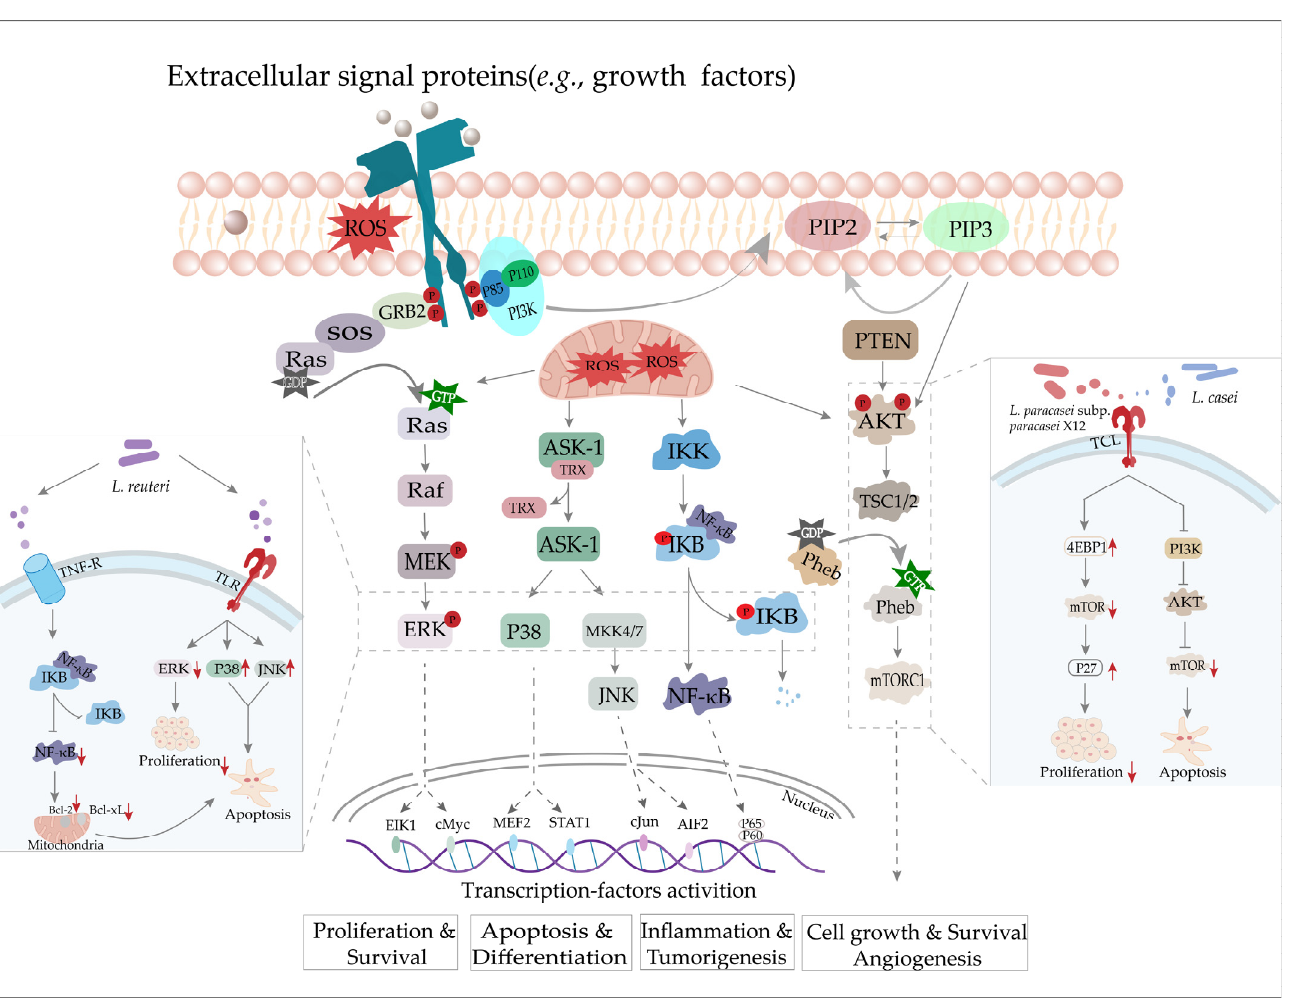
Figure 2. ROS induces the activation of the MAPK, NF- κ B, and PI3K/PTEN signaling pathways to promote cancer development, progression, and apoptosis, etc. and aa possible target of LAB [59].